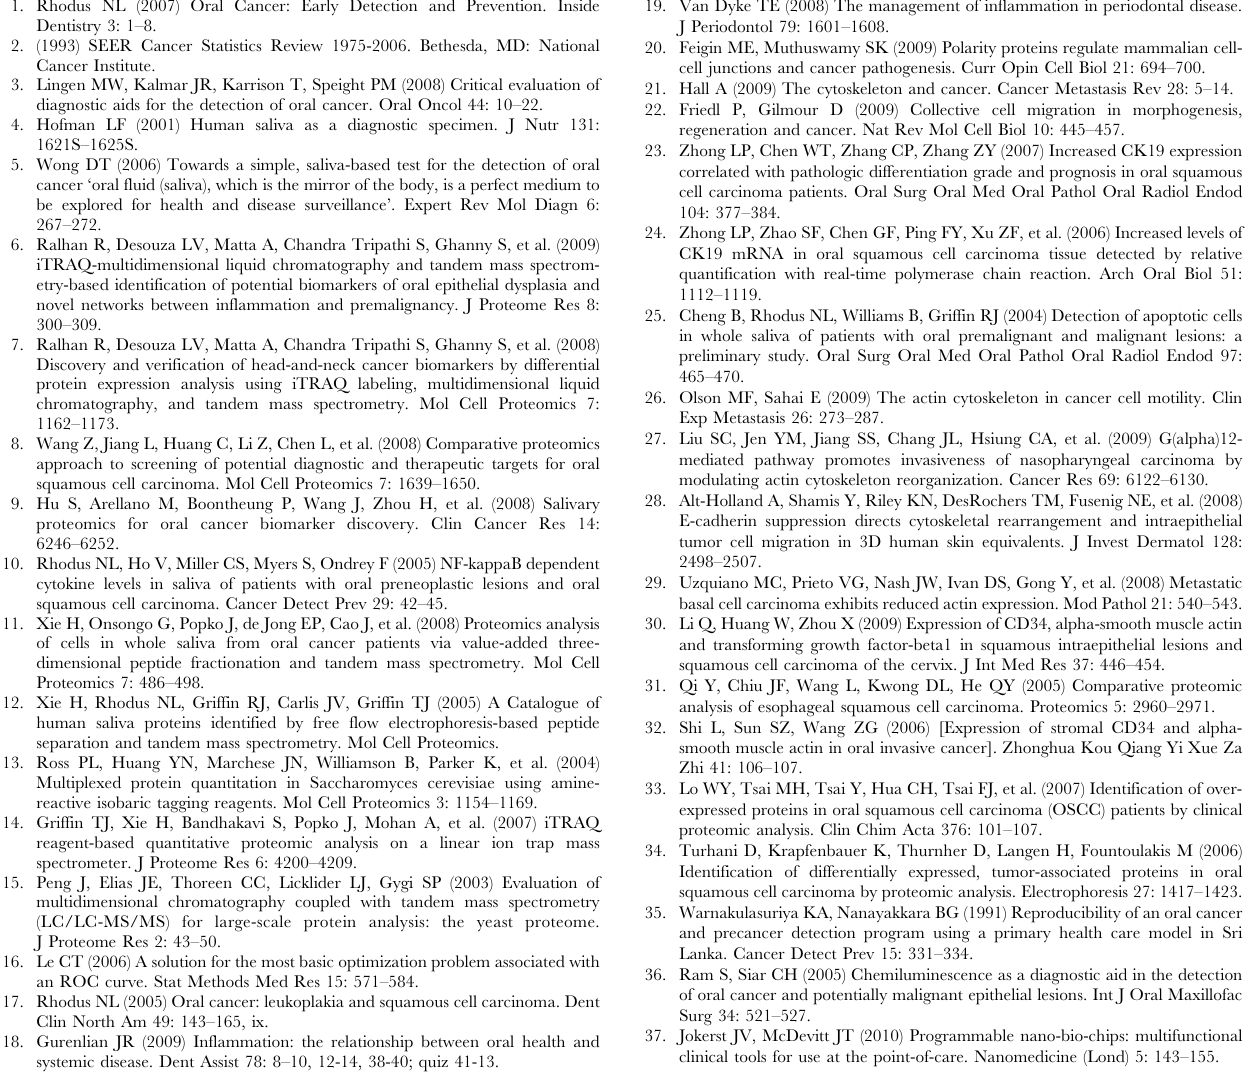
Table S1 Information on subjects used in discovery and validation studies.